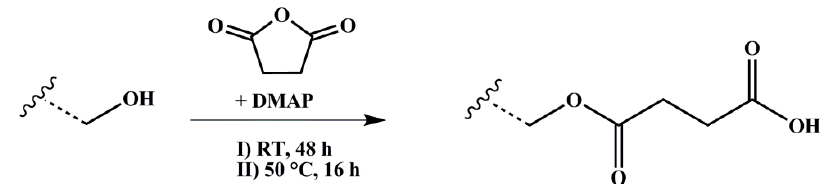
Figure 4. Reaction scheme for carboxylation of hydroxylated polymers with SA (succinic anhydride) and DMAP (4 ‐ (dimethylamino)pyridine) as catalyst. Wavy lines represent the polymeric main chain.